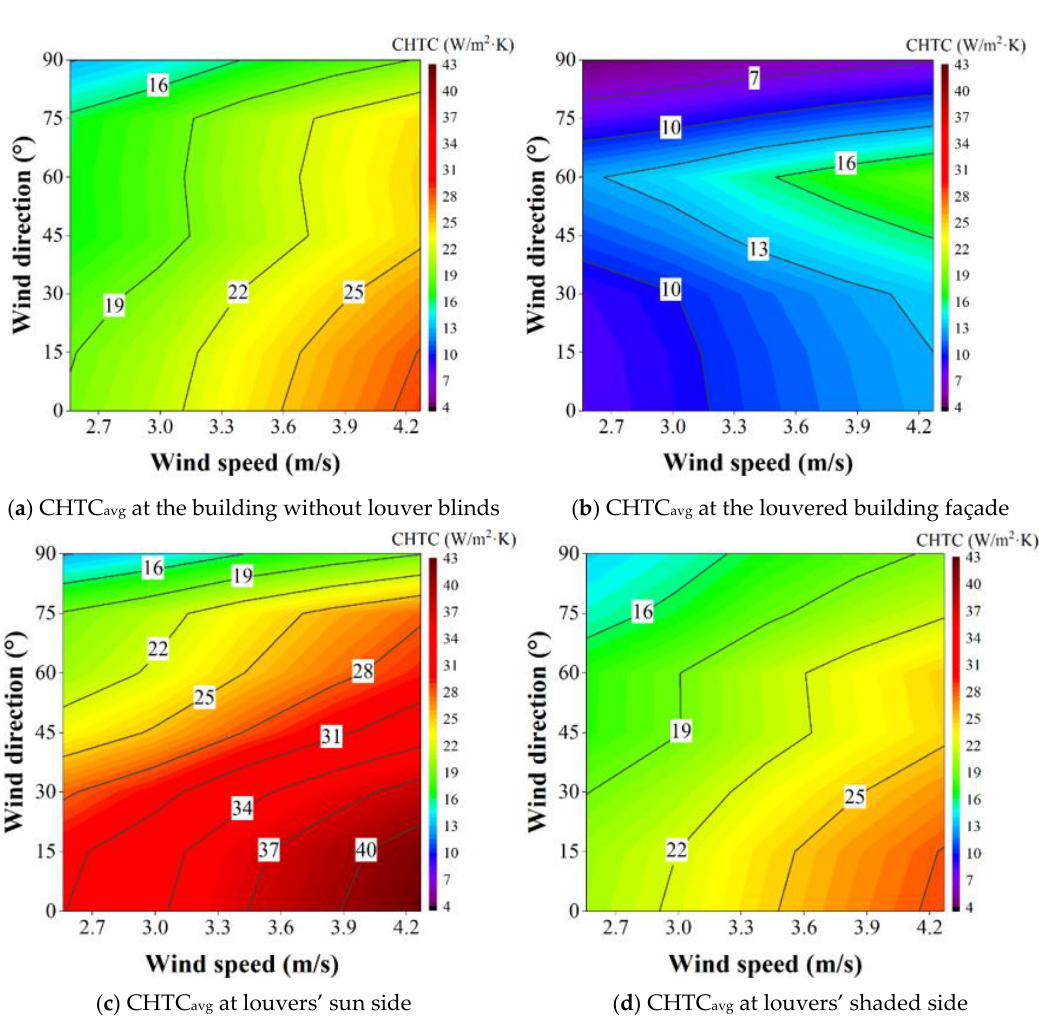
Figure 8. The change in CHTC avg of the façade and louvers with different wind directions ( D = 0.05